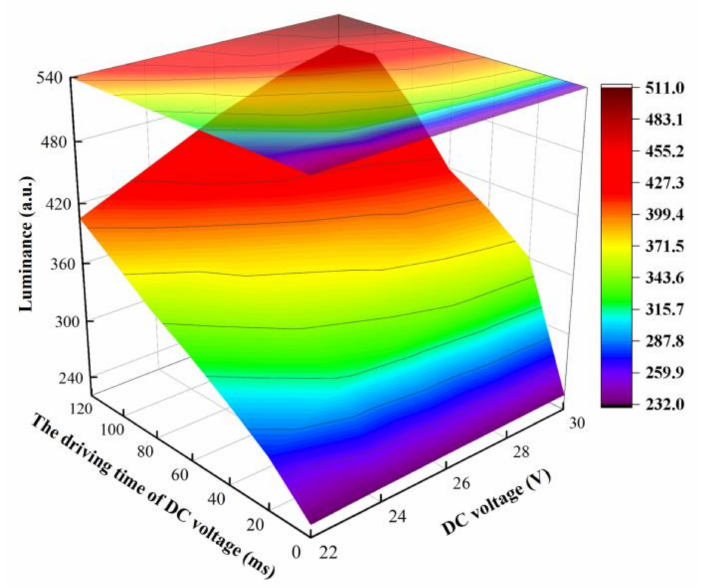
Figure 9. The luminance was changed with different V p s and t 2 s in the proposed driving waveform. A maximum luminance could be gained when V p and t 2 were set to 30 V and 100 ms, respectively.